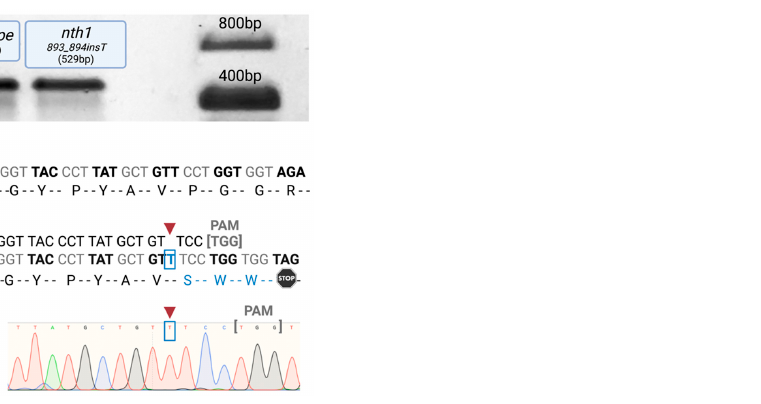
Figure 2. Confirmation of NTH1 gene disruption in S. cerevisiae by CRISPR/Cas9. ( A ). Amplification of the segment containing the expected mutation site on a 1% m/v agarose gel; ( B ). Sequencing of the S. cerevisiae NTH1 gene revealed the insertion of a T in position 893 resulting in a truncated 301 AA protein with SWW* instead of PGGR. Image created with BioRender.com (accessed on 30 March 2022). Table 1. Predicted Open Reading Frames (ORF) of mutants in comparison with the wild-type NTH1 and NTH2